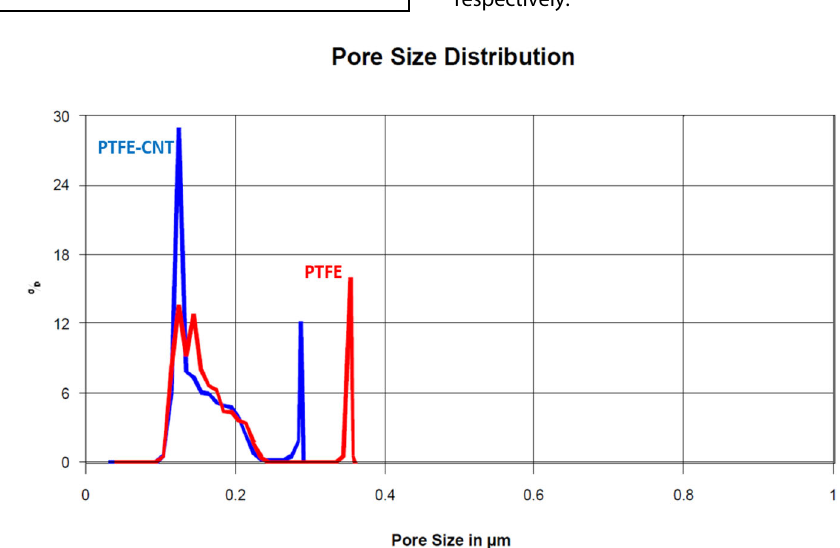
Fig. 1 Percentage pore size distribution of PTFE and PTFE-CNT